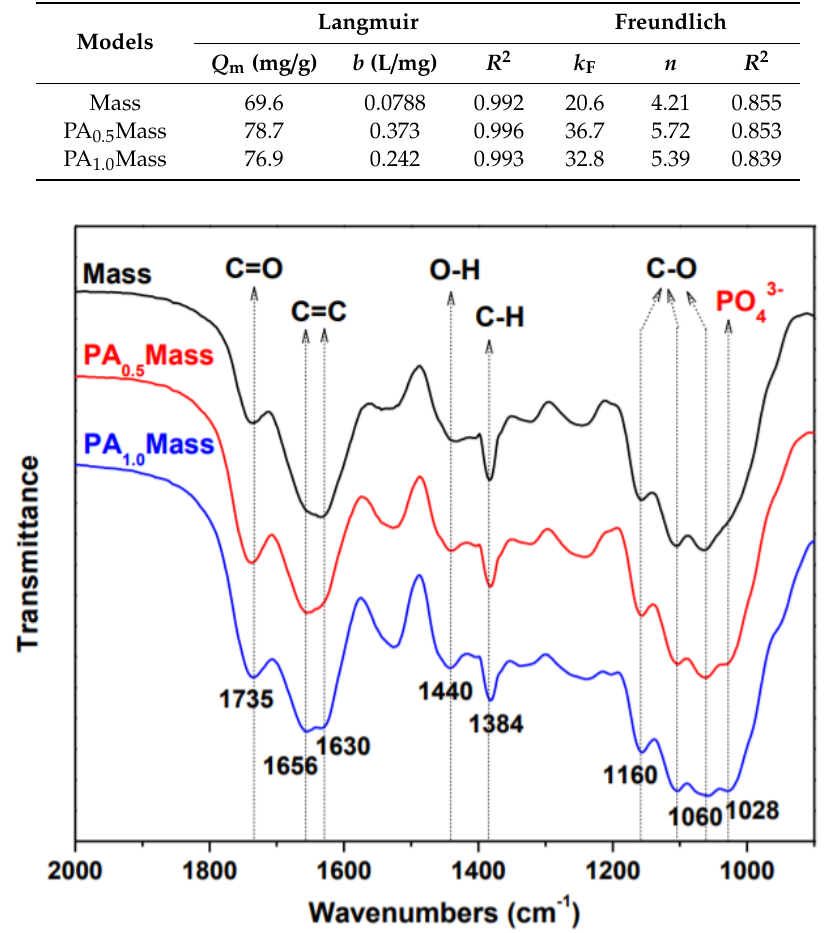
Figure 3. IR spectra of the Hydrocotyle biomass and its PA-pretreated derivatives.